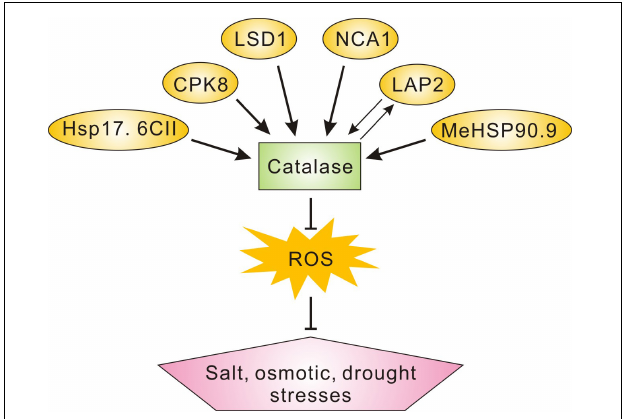
FIGURE 7 | A scheme showing the catalase-interacting proteins involved in plant salt, osmotic, or drought stress tolerance. Catalase-interacting proteins including NCA1, LSD1, CPK8, MeHSP90.9, and Hsp17.6II in previous reports as well as LAP2 in this study play roles in plant salt, osmotic, and/or drought stresses tolerance through the regulation of catalase activity and ROS